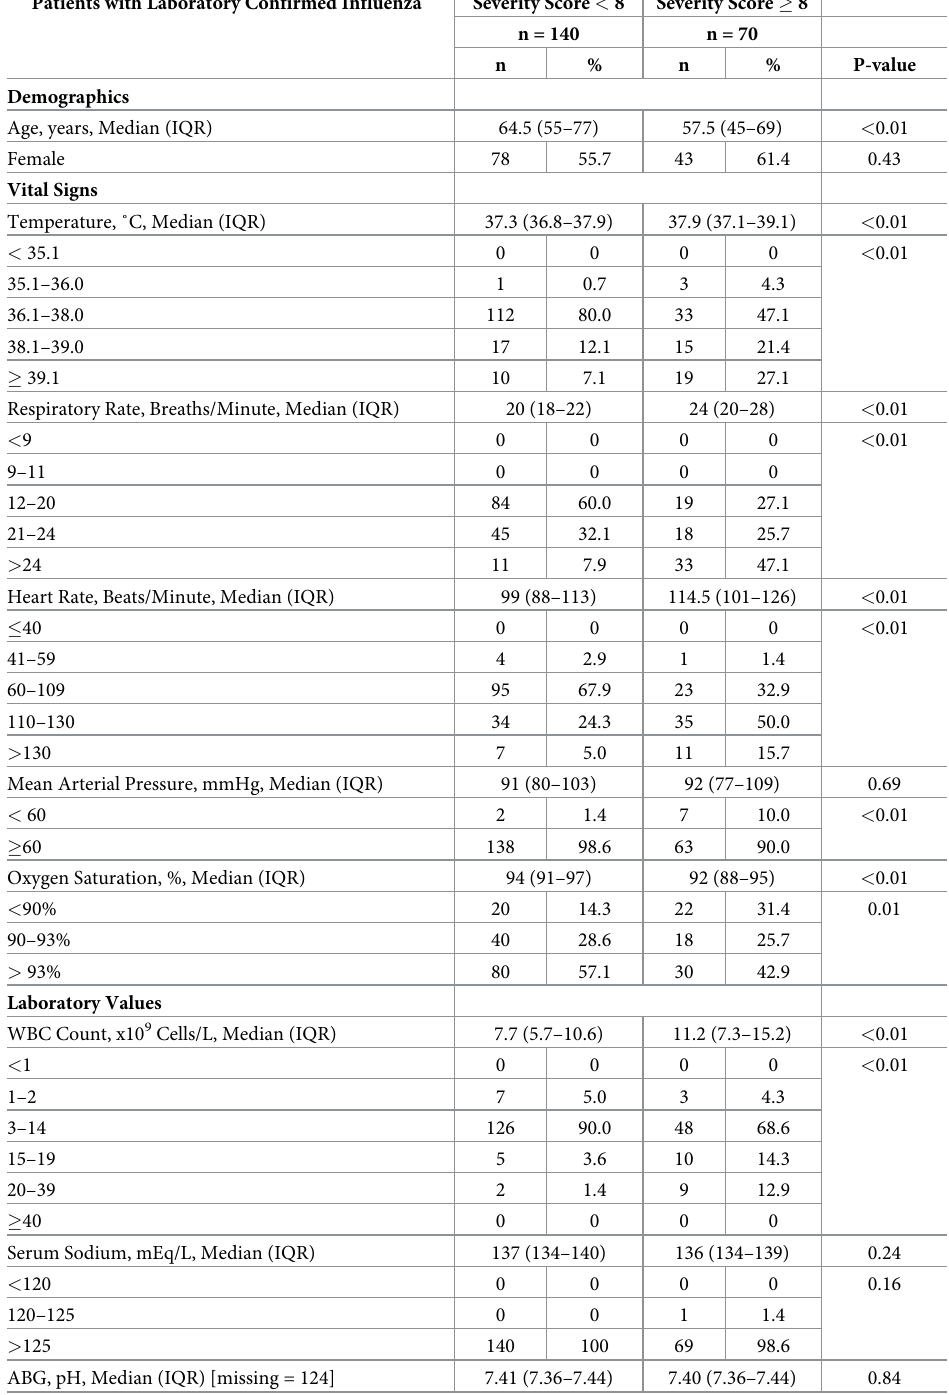
Table 4. Physiologic features and interventions among hospitalized influenza-positive patients by severity